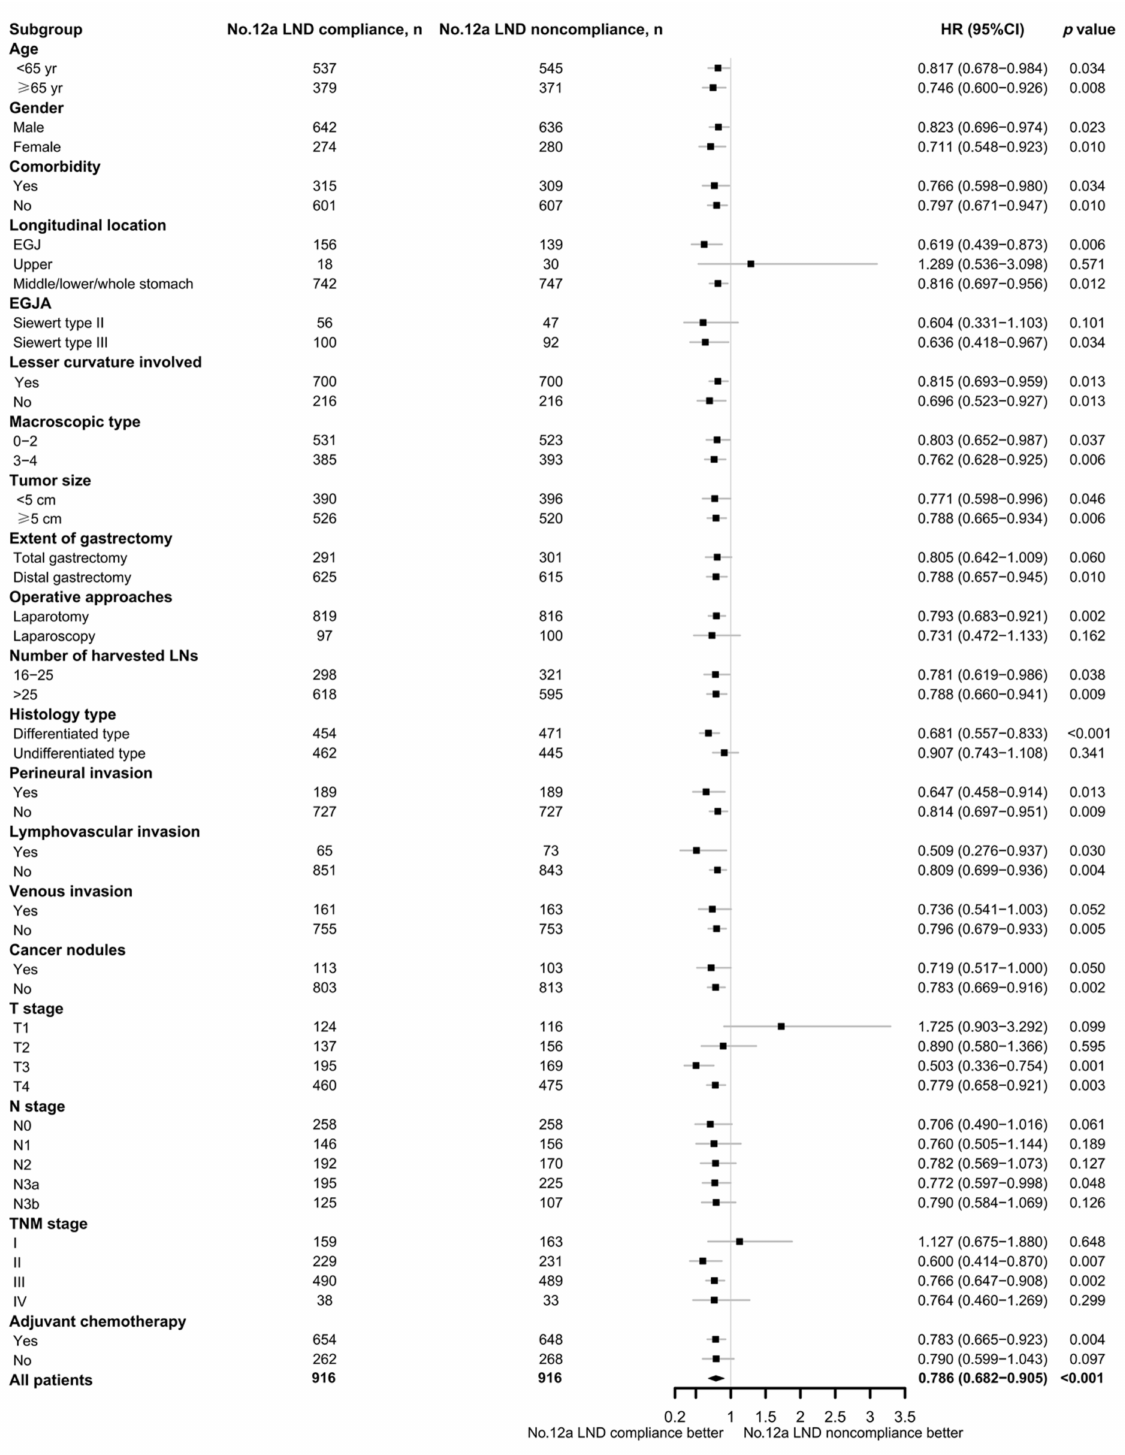
Figure 3. Forest plot of the subgroup